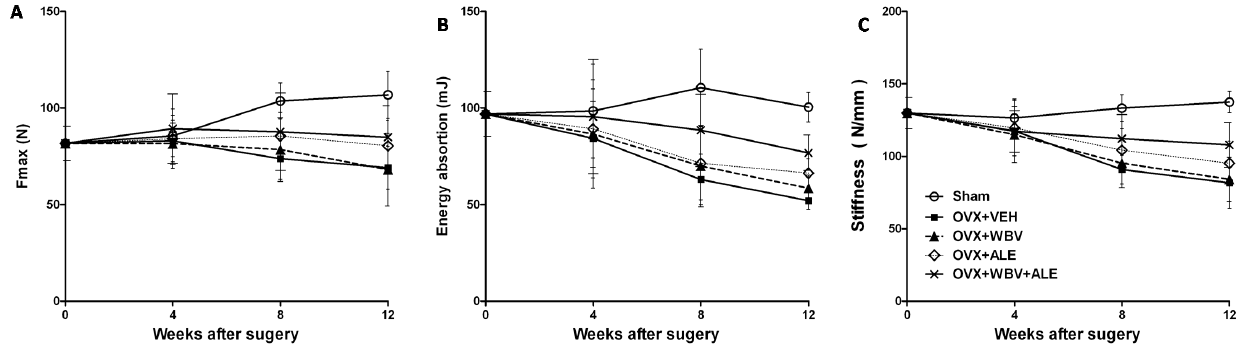
Figure 5. Change in the mechanical property at the metaphyseal tibia as measured using the three-point bending test. Each value was obtained from the right tibia of the rats. Data were presented as the mean 6